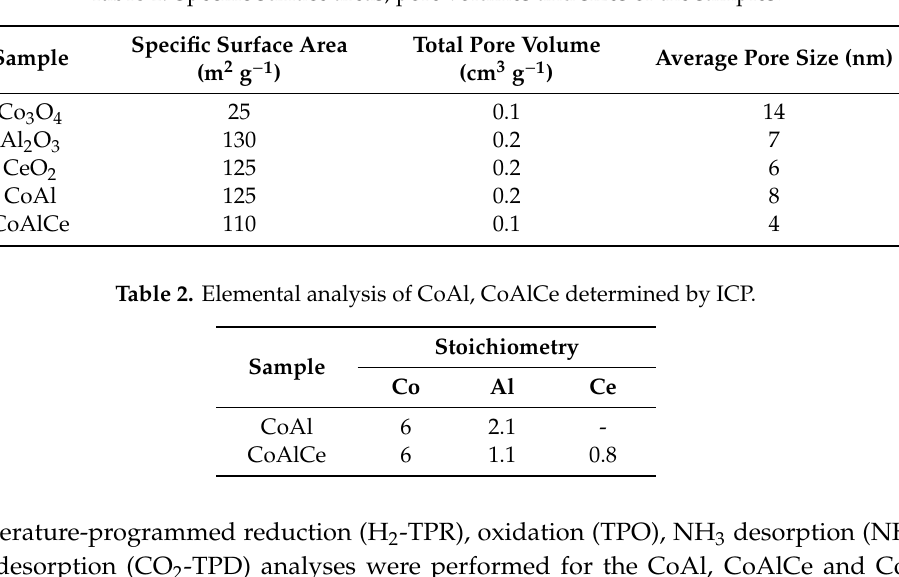
Table 1. Specific surface areas, pore volumes and sizes of the samples.